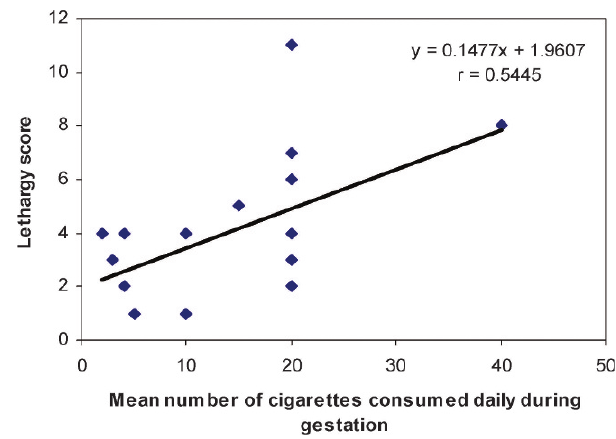
Figure 2 - Correlation between the number of cigarettes consumed during gestation (X) and neonatal lethargy score